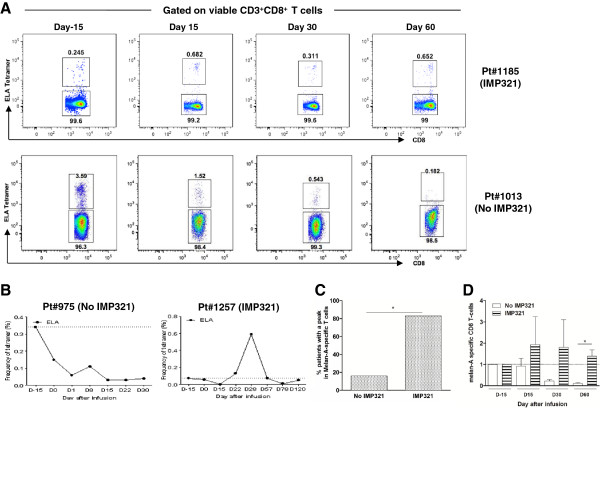
Kinetic of MART-1-specific CD8 T-cell responses following immunization. A. Representative example of the increase in the frequency of circulating MART-1-specific CD8 T cells in Pt#1185 and Pt#1013 following infusion. MART-1-specific CD8 T cells are identified using peptide-MHC class I multimer complexes and plots are gated on viable CD3+CD8+ T cells. B. Prototypic examples of the kinetic of MART-1-specific CD8 T cells in patients from the IMP321 or no IMP321 groups. Dotted lines represent the initial frequency of MART-1-specific CD8 T cells prior to lymphodepletion. C. Proportion of patients from each group with a peak in the frequency of MART-1-specific CD8 T cells. Peaks were defined as a frequency of MART-1-specific CD8 T cells > three-fold higher than baseline, i.e. D-15 (n = 6 for each group, *P < 0.02). D. Cumulative analysis of the fold increase of MART-1-specific CD8 T cells overtime in the different groups. Mean + SEM are shown (n = 6 for each group, *P < 0.02).